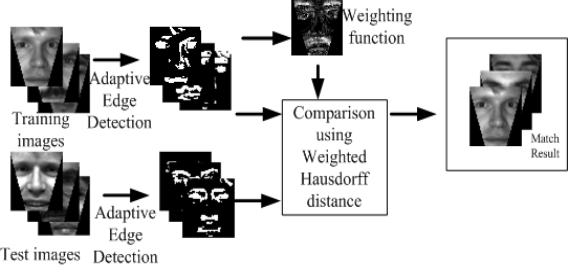
Fig. 4 Framework of face recognition